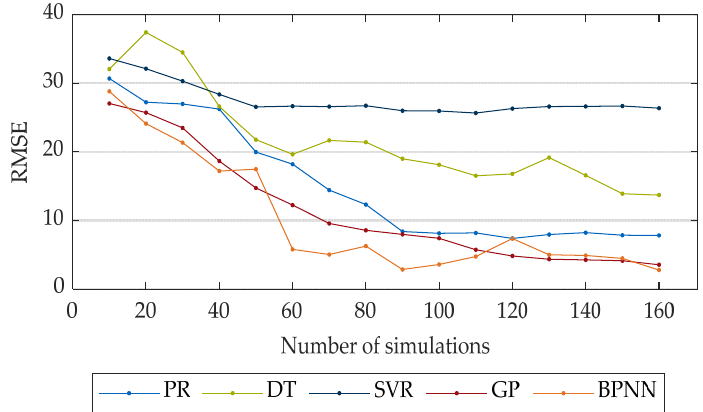
Figure 10. RMSE scores for the test sets as a function of the data volume for Use Case 1.